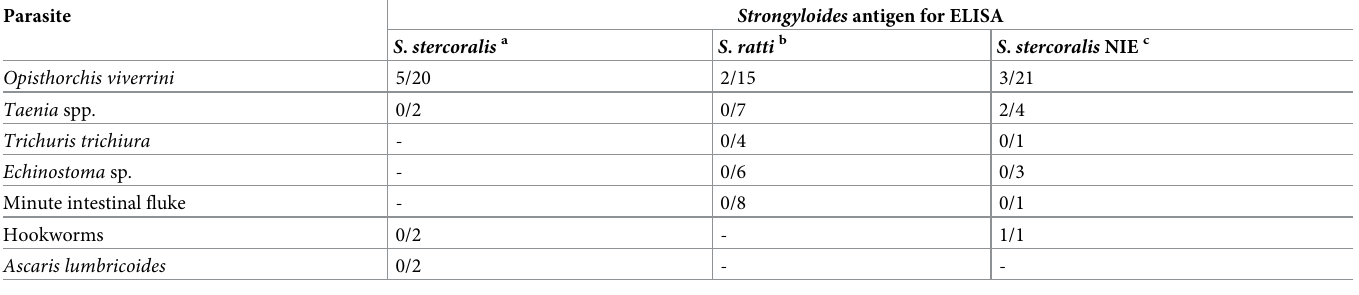
Table 3. Reactivity of serum and urine ELISA protocols based on S . stercoralis , S . ratti and S . stercoralis NIE